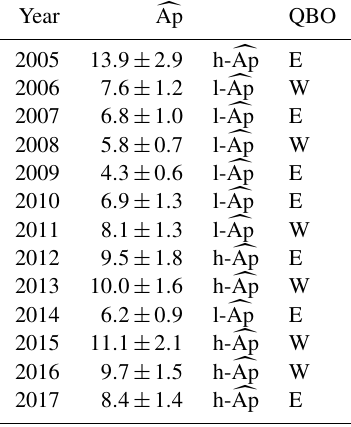
Table 1. The average Ap from May to August ( (cid:99) Ap ± 2 × standard error of the mean), designation to high- or low-Ap group (“h- (cid:99) Ap” for high Ap and “l- (cid:99) Ap” for low Ap: for (cid:99) Ap higher or lower than 8.3 respectively), and the phase of the QBO (E denotes east- erly, and W denotes westerly) in May for each of the years included in the